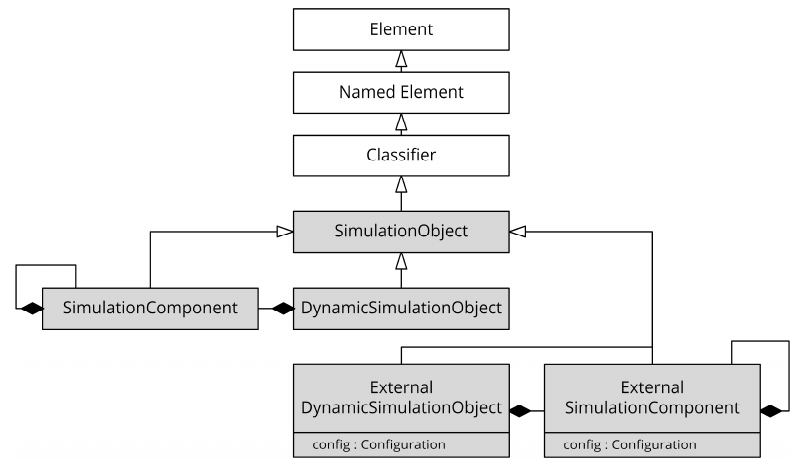
Figure 17. Simplified view on the introduced SimulationObject meta-modeling concepts (cf. Section 5.2). White boxes represent existing UML metamodel elements and gray boxes represent newly added ones.